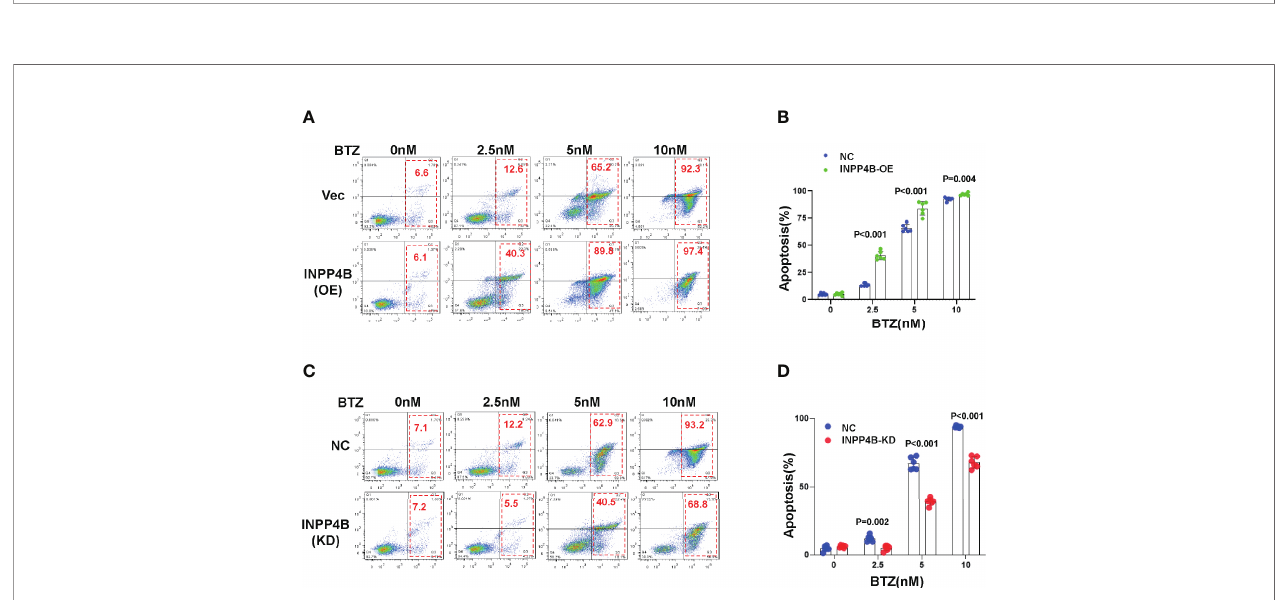
FIGURE 5 | INPP4B promotes chemosensitivity to proteasome inhibitor in MM cells. (A) Flow cytometry assay showed the apoptosis of MM.1S cells infected with lentiviral-carrying INPP4B expressing vector and treated with different dosage of bortezomib (BTZ) for 48 h, and (B) showed the statistical analysis for three independent experiments. (C) Flow cytometry assay showed the apoptosis of MM.1S cells infected with lentiviral-carrying shRNA targeting INPP4B and treated with different dosage of bortezomib (BTZ) for 48 h, and (B) showed the statistical analysis for three independent